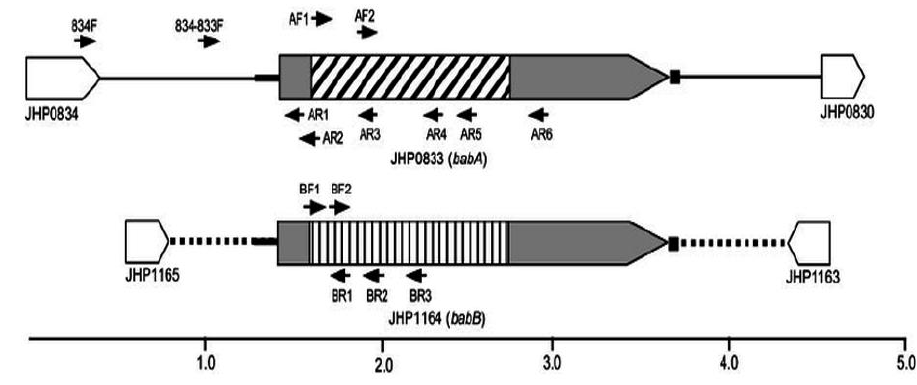
Fig. 4. Represented Bab gene of H. pylori (Henriksson et al.,